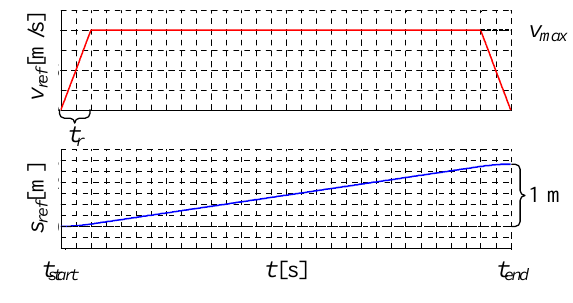
Figure 8: Velocity and position